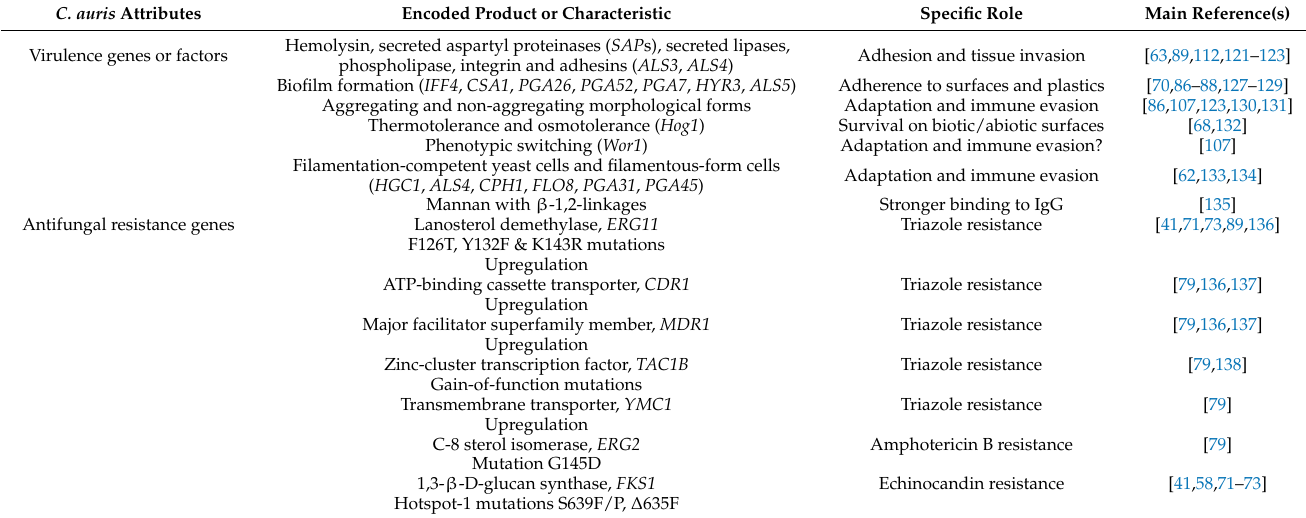
Table 3. C. auris virulence factors and genes conferring resistance to antifungal